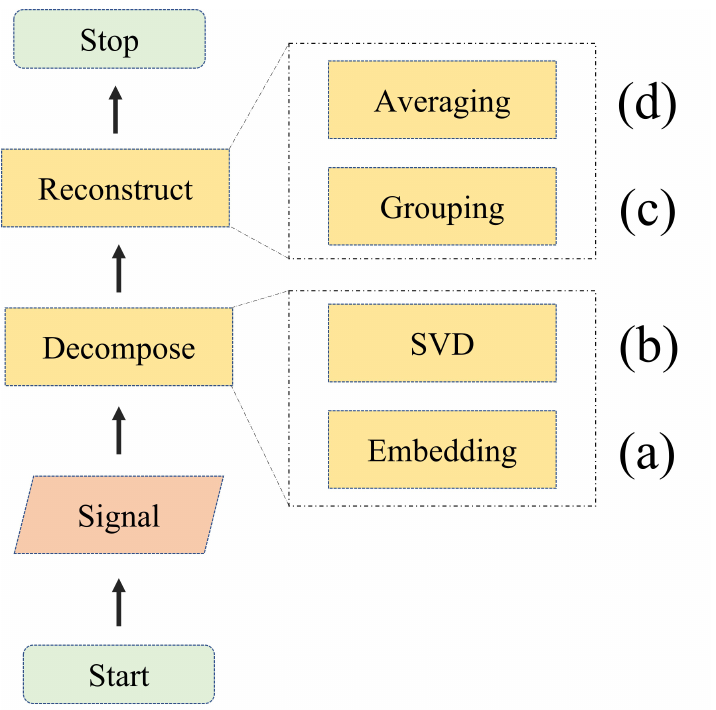
Figure 1. The structure of SSA algorithm, ( a ) shows embedding process block, ( b ) shows SVD process block, ( c ) shows grouping process block and ( d ) shows averaging process